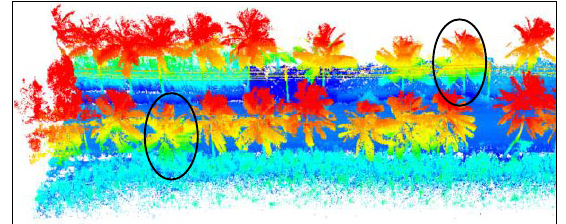
Figure 2. Point cloud view of input test site.